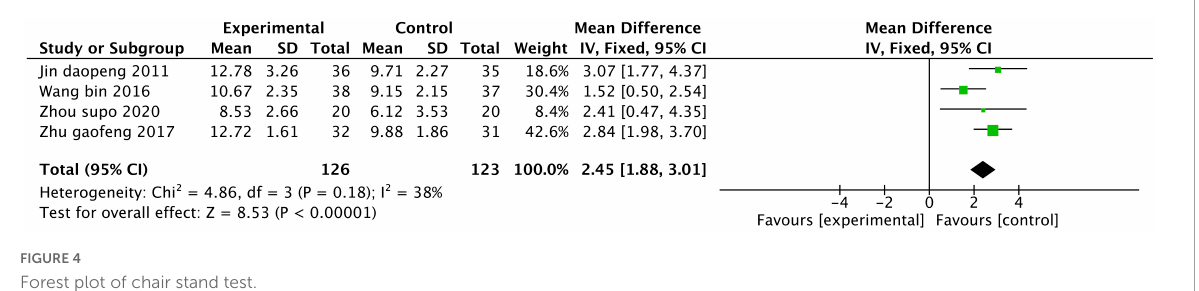
FIGURE4 Forest plot of chair stand test.